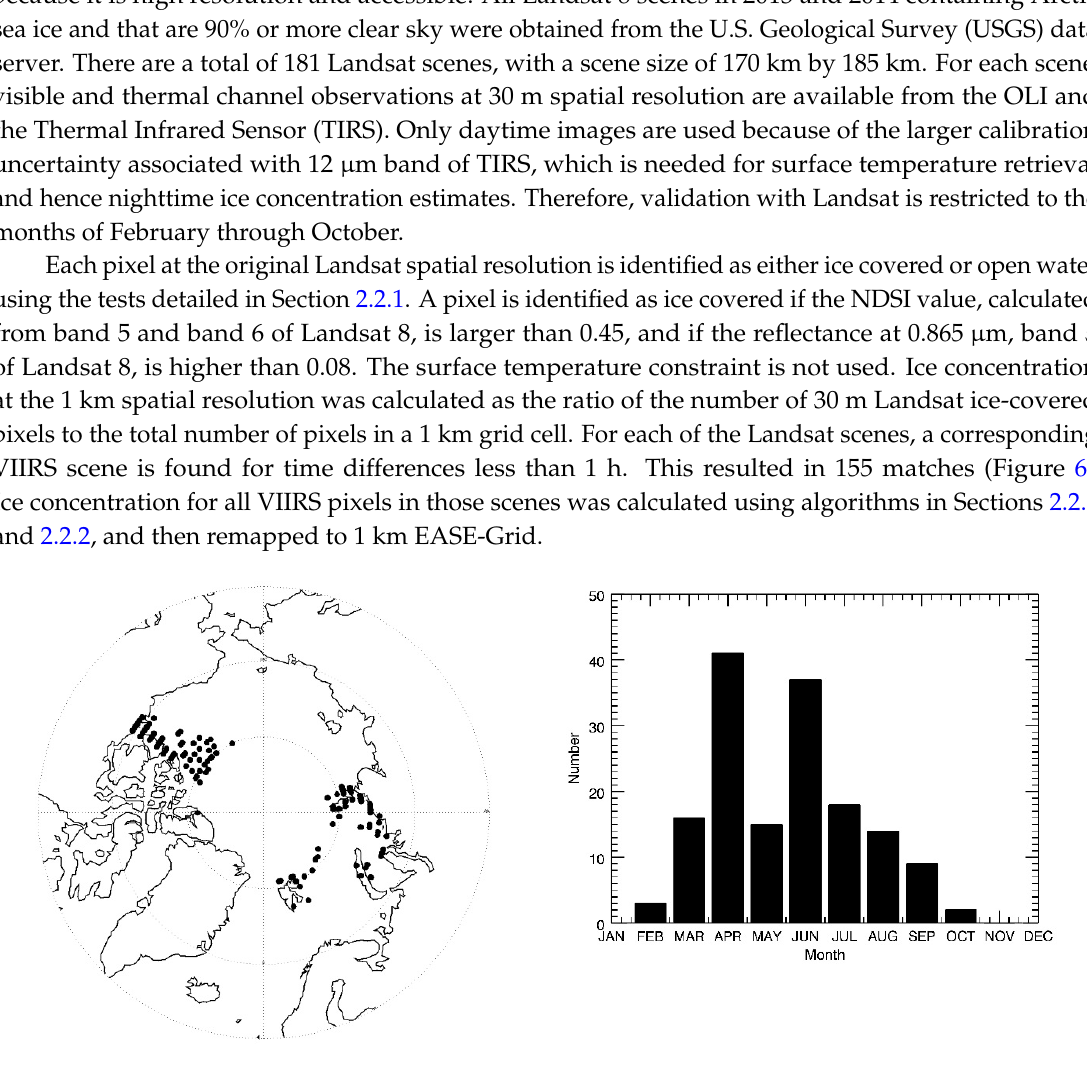
Figure 6. ( left ) spatial distribution of the center point of 155 Landsat 8 scenes; and ( right ) the monthly distribution of scenes.